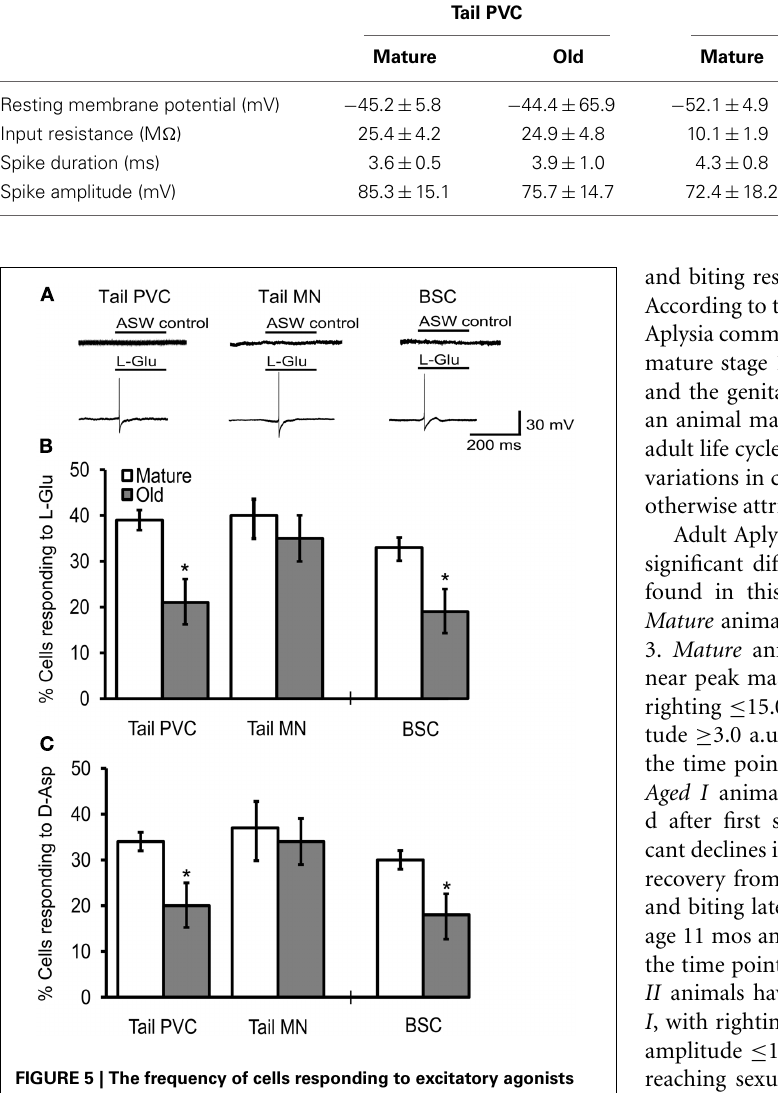
FIGURE 5 | The frequency of cells responding to excitatory agonists with an AP declined in tail PVC and BSC sensory neurons of intact preparations. (A) Application of 1mM L-Glu or D-Asp evoked excitatory discharge in sensory and motor neurons of intact preparations while application of ASW alone did not. Tail PVC and BSC sensory neurons were quiescent until agonist was applied. Tail motoneurons were held at −